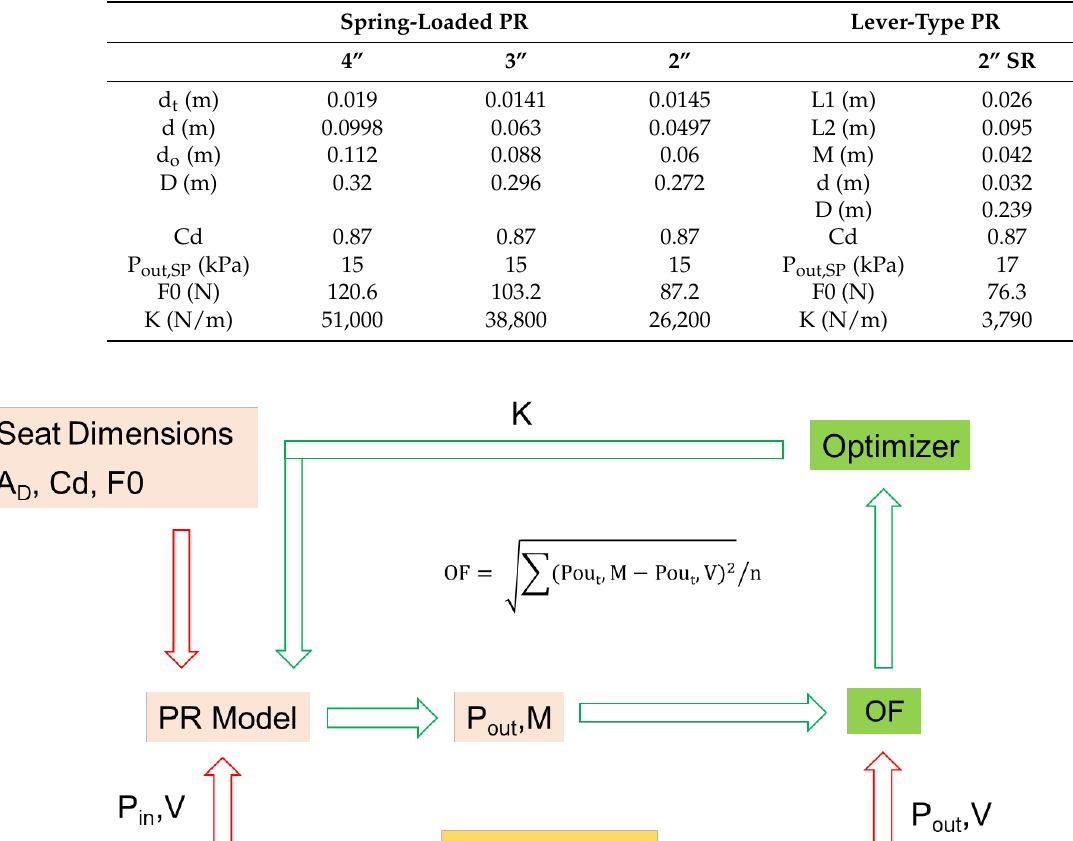
Table 1. The dimensions and model parameters for the two PRs.